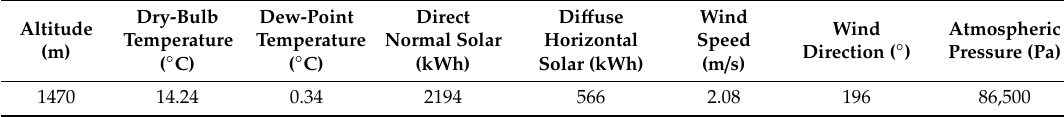
Table 1. Climatic information of Palangan.